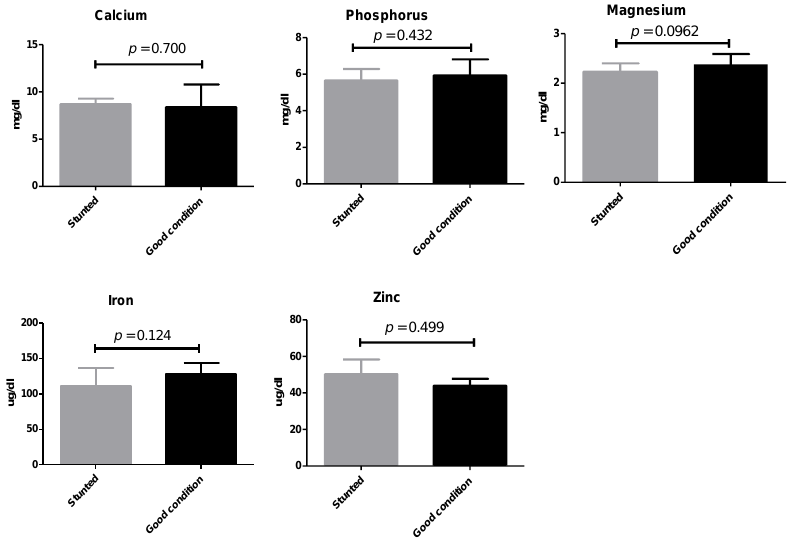
Similarly, non-statistically significant variations ( p = >0.05) were observed when a